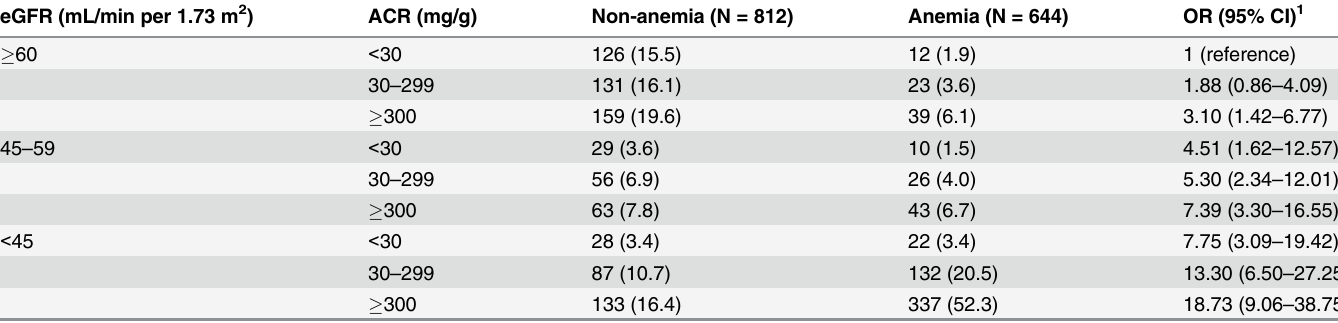
Table 3. Odds ratios for anemia based on the cross-categorization of albuminuria and the eGFR. eGFR (mL/min per 1.73 m 2 ) ACR (mg/g) Non-anemia (N =